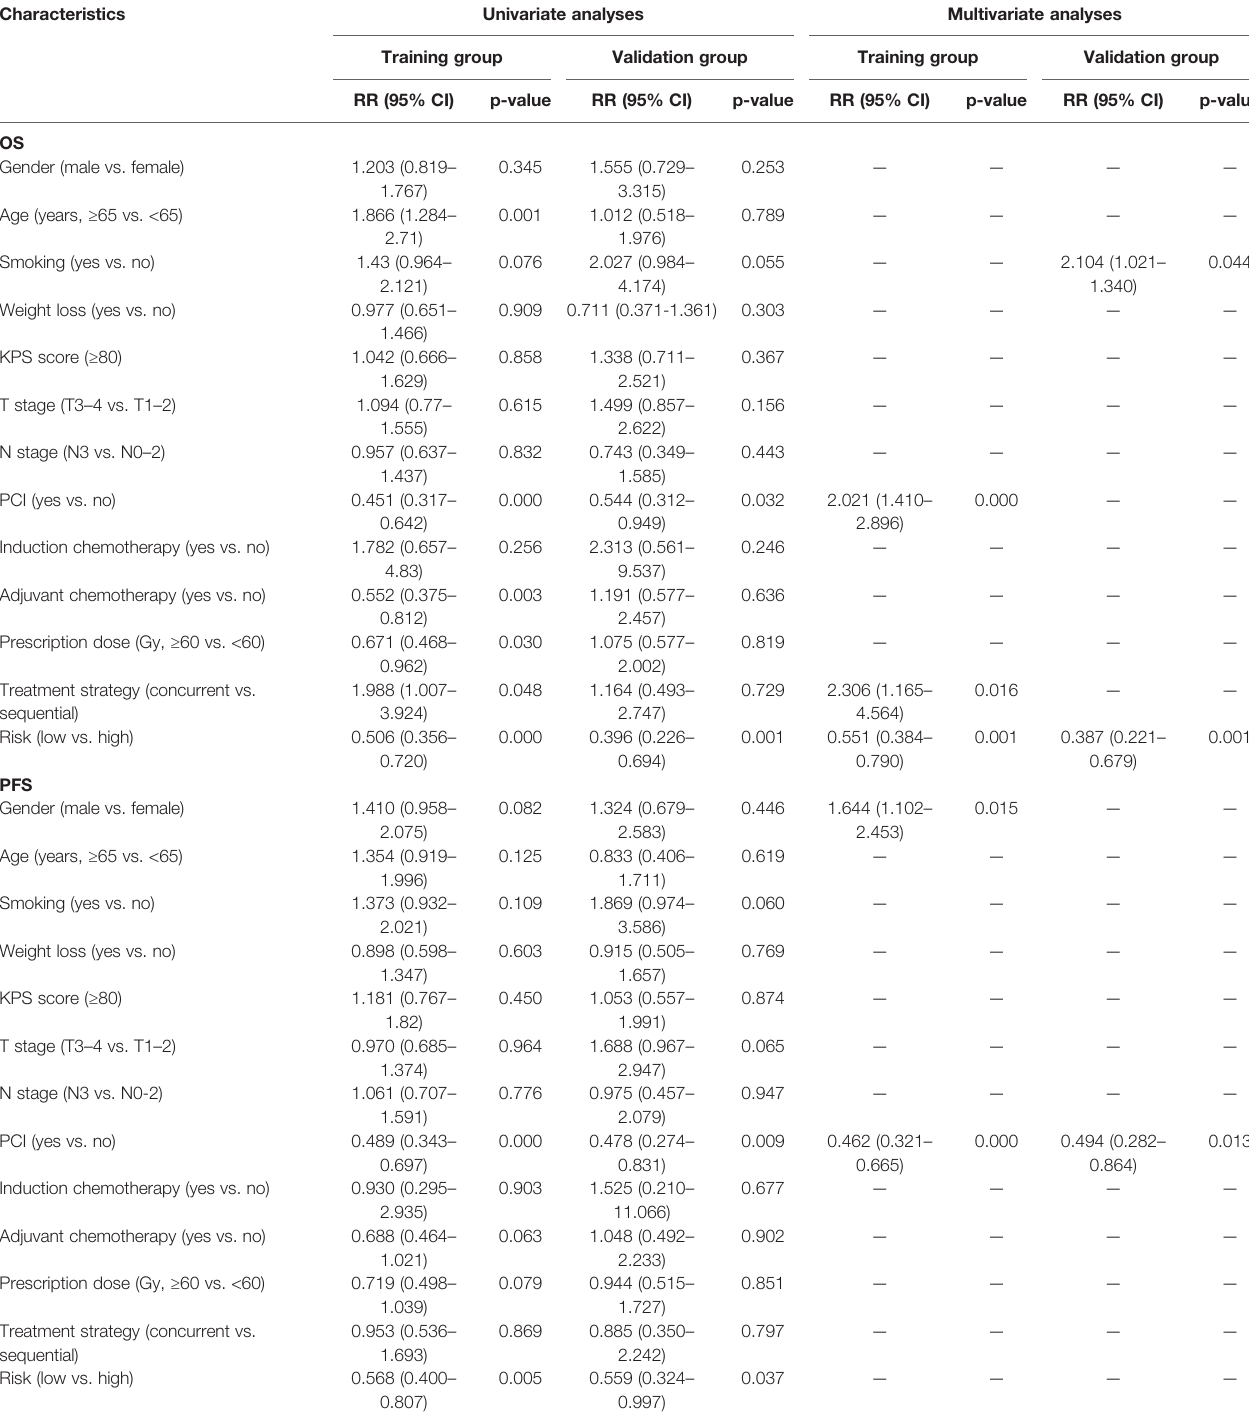
TABLE 4 | Univariate and multivariate Cox analyses of baseline characteristics and Risk on survival in limited-stage small cell lung cancer patients.